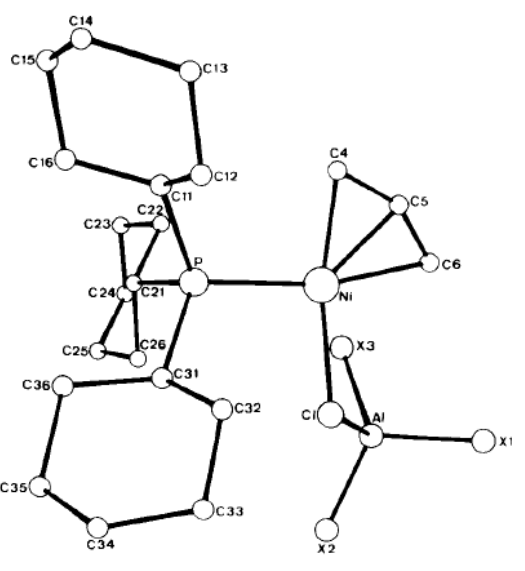
Figure 38. The molecular structure of complex Ni01 comprising η 3 -allylnickel chloride, PCy 3 , and MeAlCl 2 (X = Cl, Me). Reprinted with permission from [269]. Copyright (1979) Elsevier B.V.